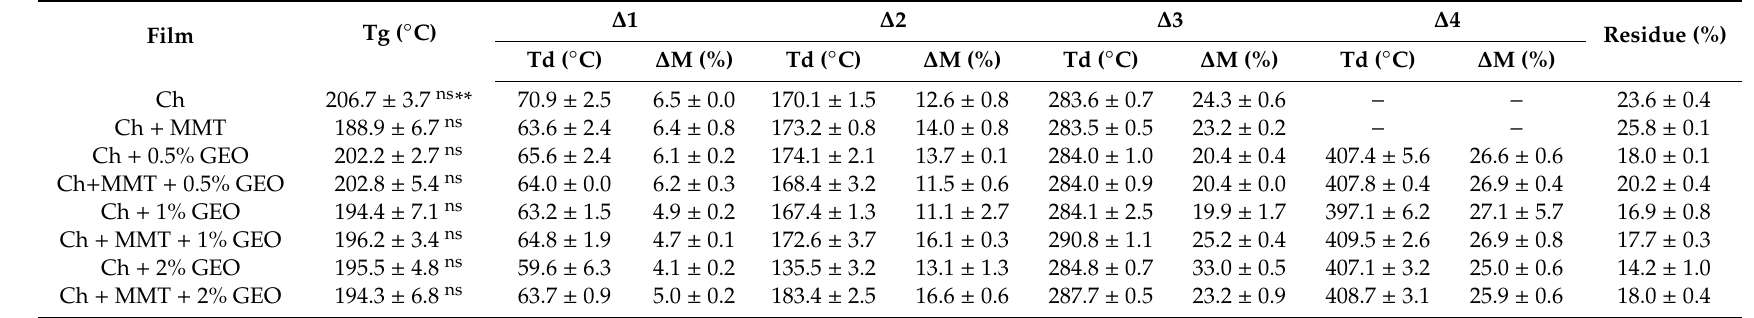
Table 1. Summary of the thermal analyses results of active